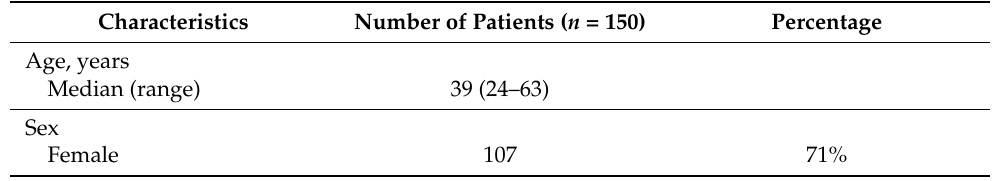
Table 2. Characteristics of ocular adnexal MALT lymphoma